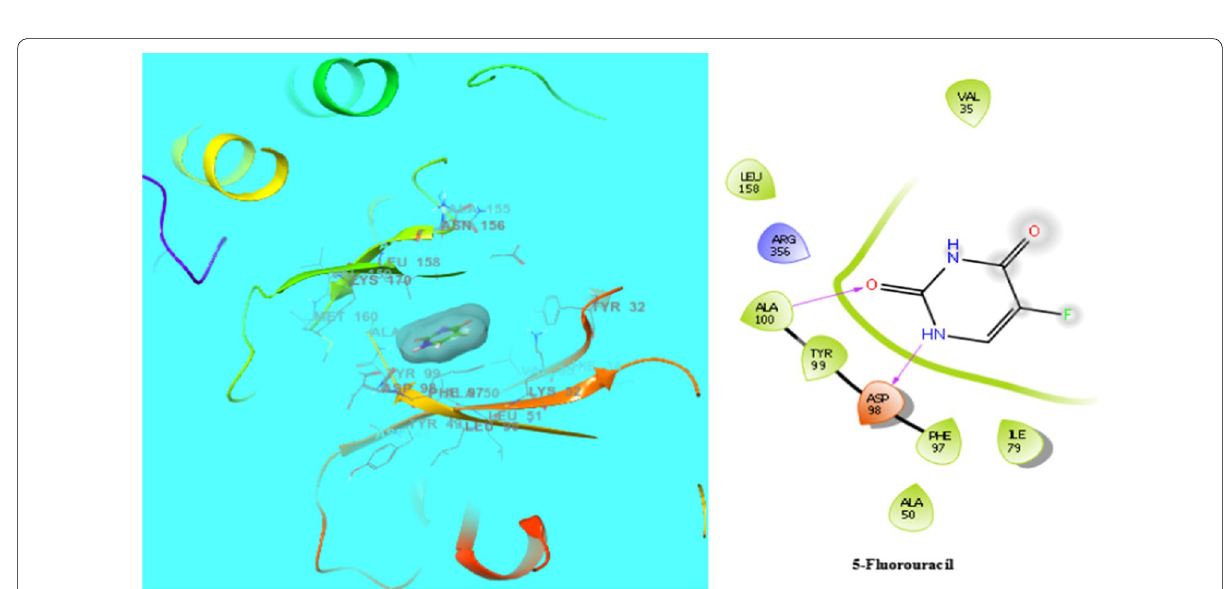
Fig. 7 Interaction of 5-fluorouracil within the active pocket of cdk-8 protein and interacting amino acid in 2D